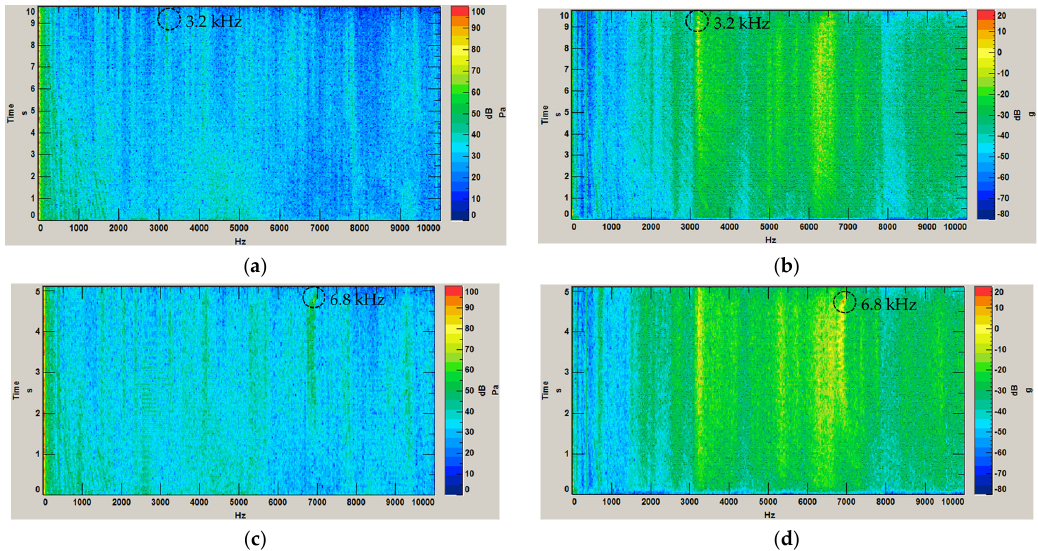
Figure 6. Color maps from brake dynamometer test: ( a ) noise (20 bar, 100 km/h), ( b ) acceleration (20 bar, 100 km/h), ( c ) noise (40 bar, 100 km/h), and ( d ) acceleration (40 bar, 100 km/h).